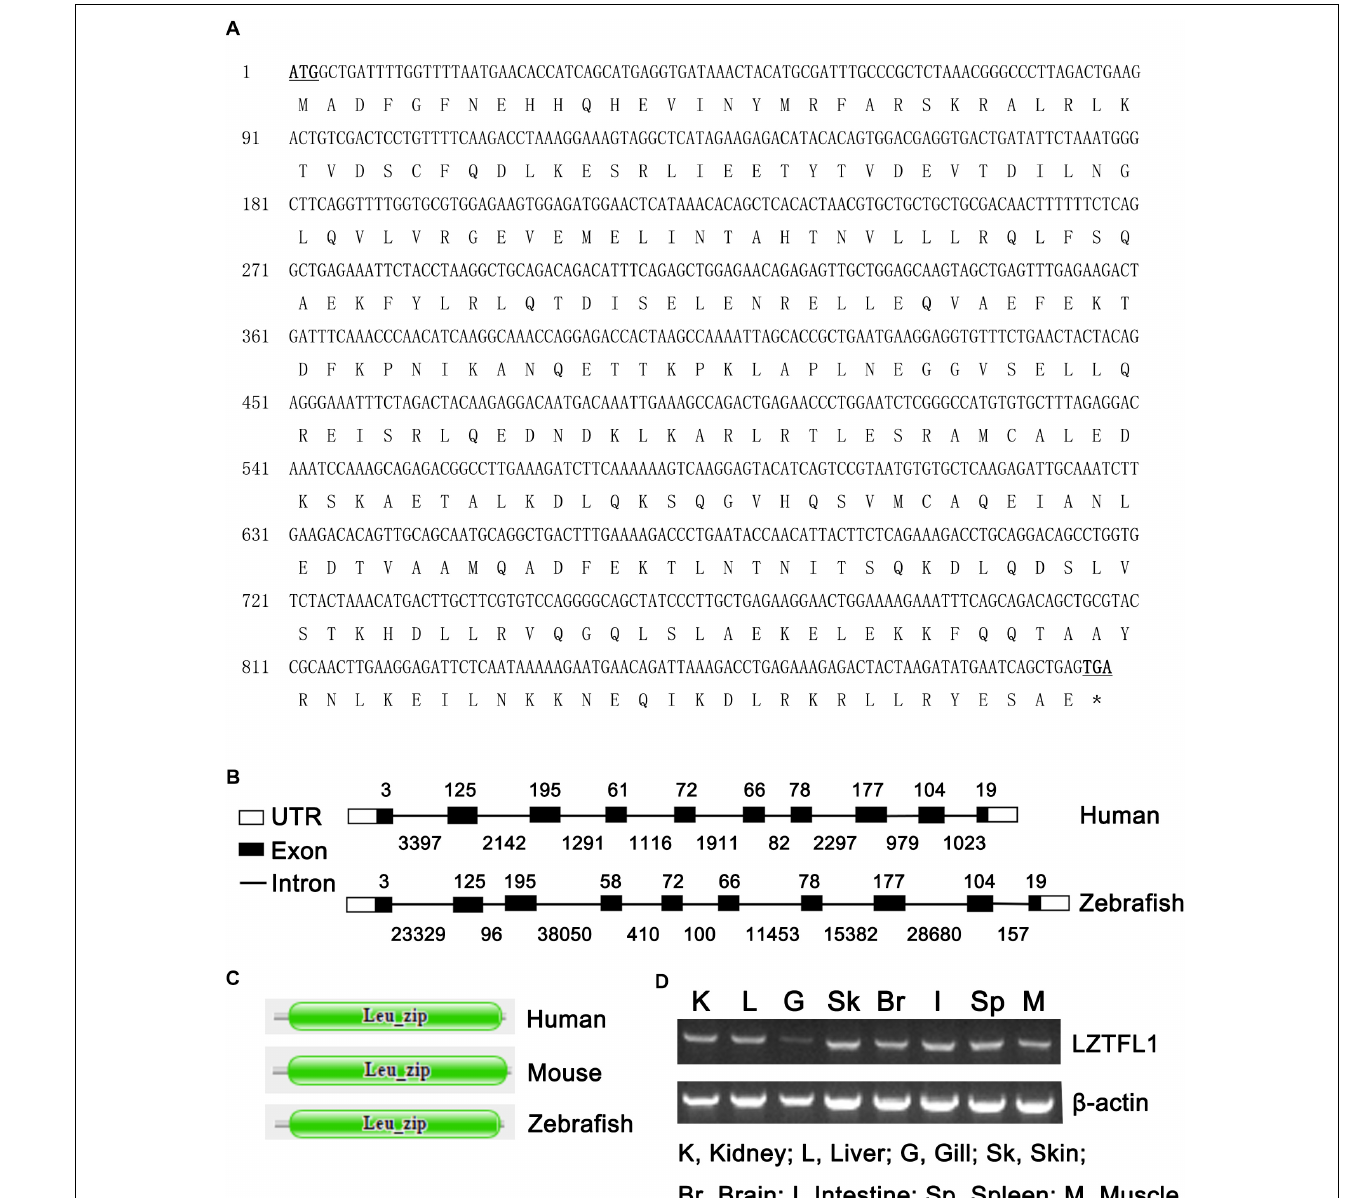
FIGURE 1 | (A) Nucleotide and deduced amino acid sequences of LZTFL1 cDNA from zebrafish (GenBank accession number MK253678). The start and stop codons are underlined and in boldface. ∗ stop codon. (B) Genomic structures of LZTFL1 genes. The rectangles represent the exons, and the lines between indicate the introns. The sizes of exons are marked above the exons, and the sizes of introns are marked below the introns. White boxes indicate 5 (cid:48) or 3 (cid:48) untranslated region (UTR), and black boxes indicate the encoding-exons. (C) Schematic representation of the domain organization of LZTFL1 proteins. Each domain was predicted by the Pfam programs. (D) Zebrafish LZTFL1 was distributed in various tissues, including kidney, liver, gill, skin, brain, intestine, spleen, and